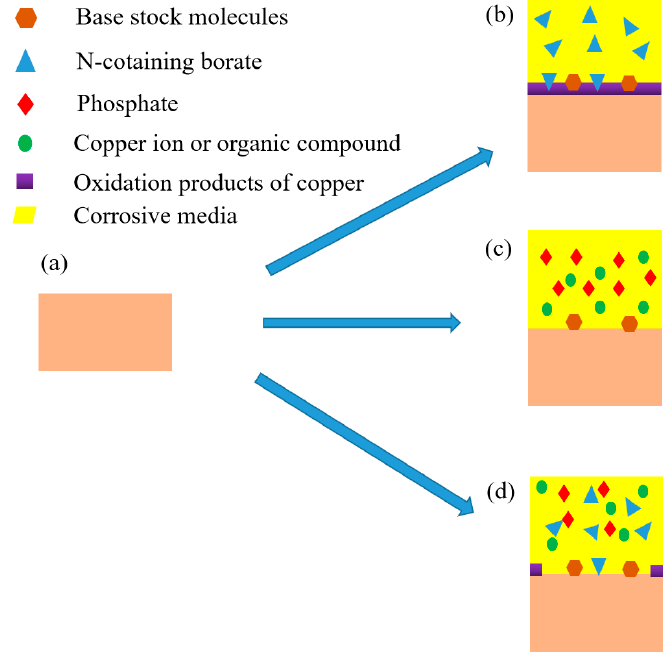
Figure 6. The original rolled copper foil ( a ) and sketches of the corroded rolled copper foil in condition E, ( b ) F ( c ) and A ( d ).